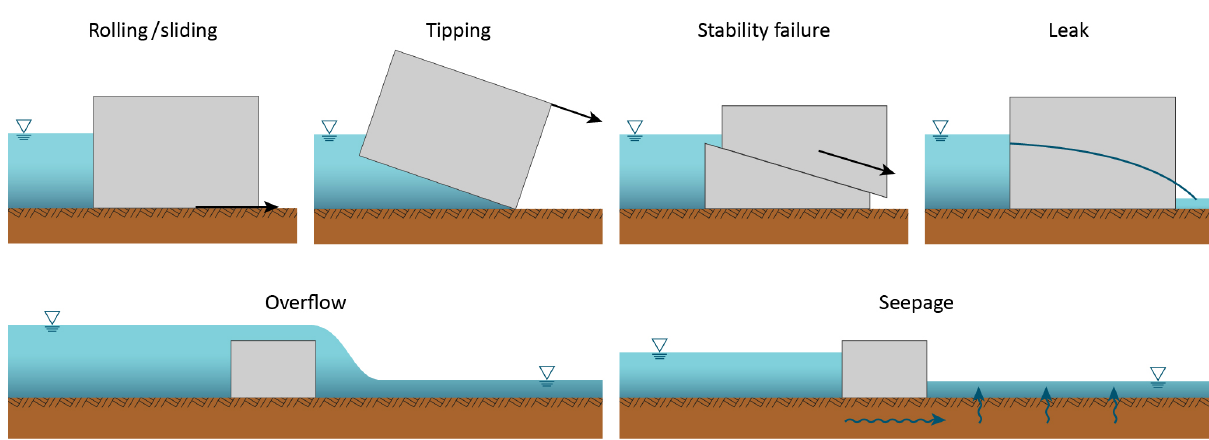
Figure 8. Typical failure mechanisms of SBRSs (BWK, 2005, modified).